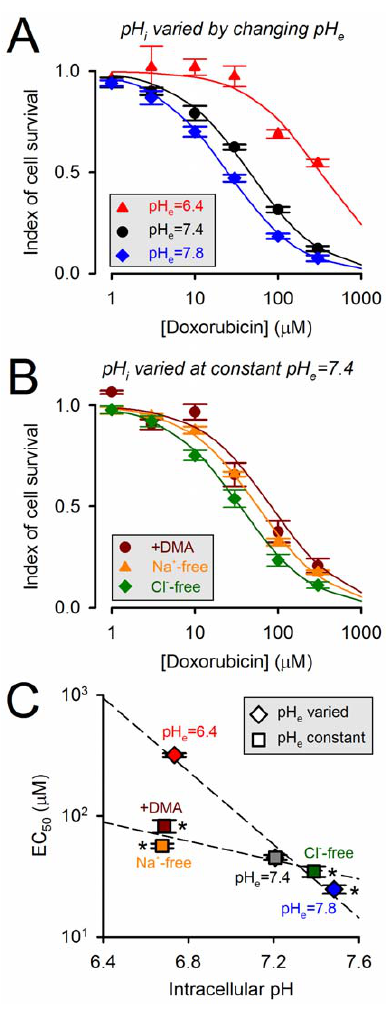
Figure 6. Doxorubicin efficacy as a function of intracellular pH. Cell proliferation was measured using the CellTiter blue assay kit (quantified as a ratio of absorbance at 562 nm and 595 nm). Doxorubicin efficacy was determined from dose-response curves as the concentration which results in a 50% decrease in proliferation (EC 50 ). EC 50 was measured under six different conditions that change pH i , with or without an associated change in pH e . (A) Determining EC 50 under incubation with normal Tyrode solutions titrated to pH 7.4 (the control), 6.4 or 7.8. Incubation under these conditions also changes pH i (n=8 each). (B) Determining EC 50 under incubation with solutions at pH e =7.4 containing 50 m M DMA or lacking Na + salts or Cl 2 salts (n=8 each). These manoeuvres change pH i by altering the balance of acid/ base fluxes across membranes (but do not alter pH e significantly because of the dilution effect into the large extracellular volume). (C) EC 50 plotted against pH i (see Fig. 4Aii). Alkaline pH i increases doxorubicin efficacy (decreases EC 50